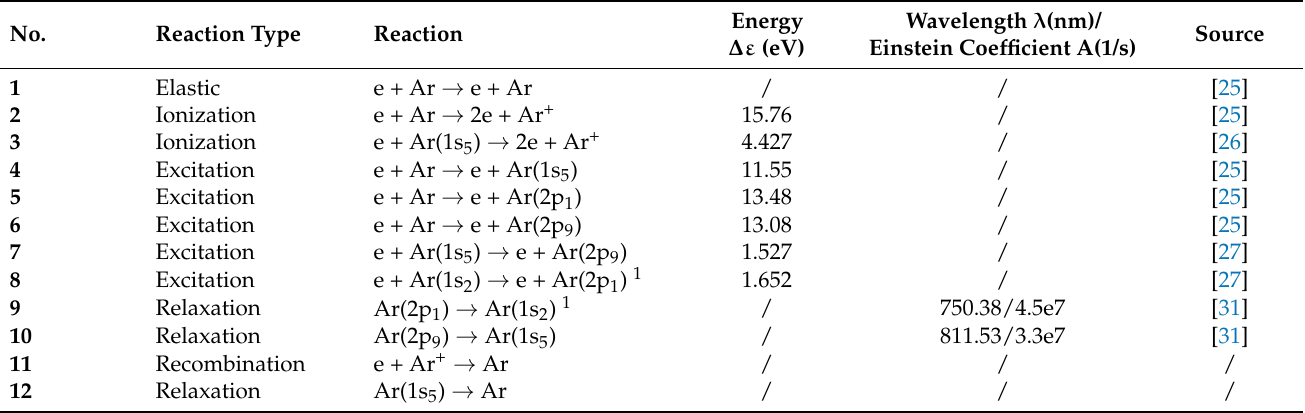
Table 4. Reactions in argon plasma.